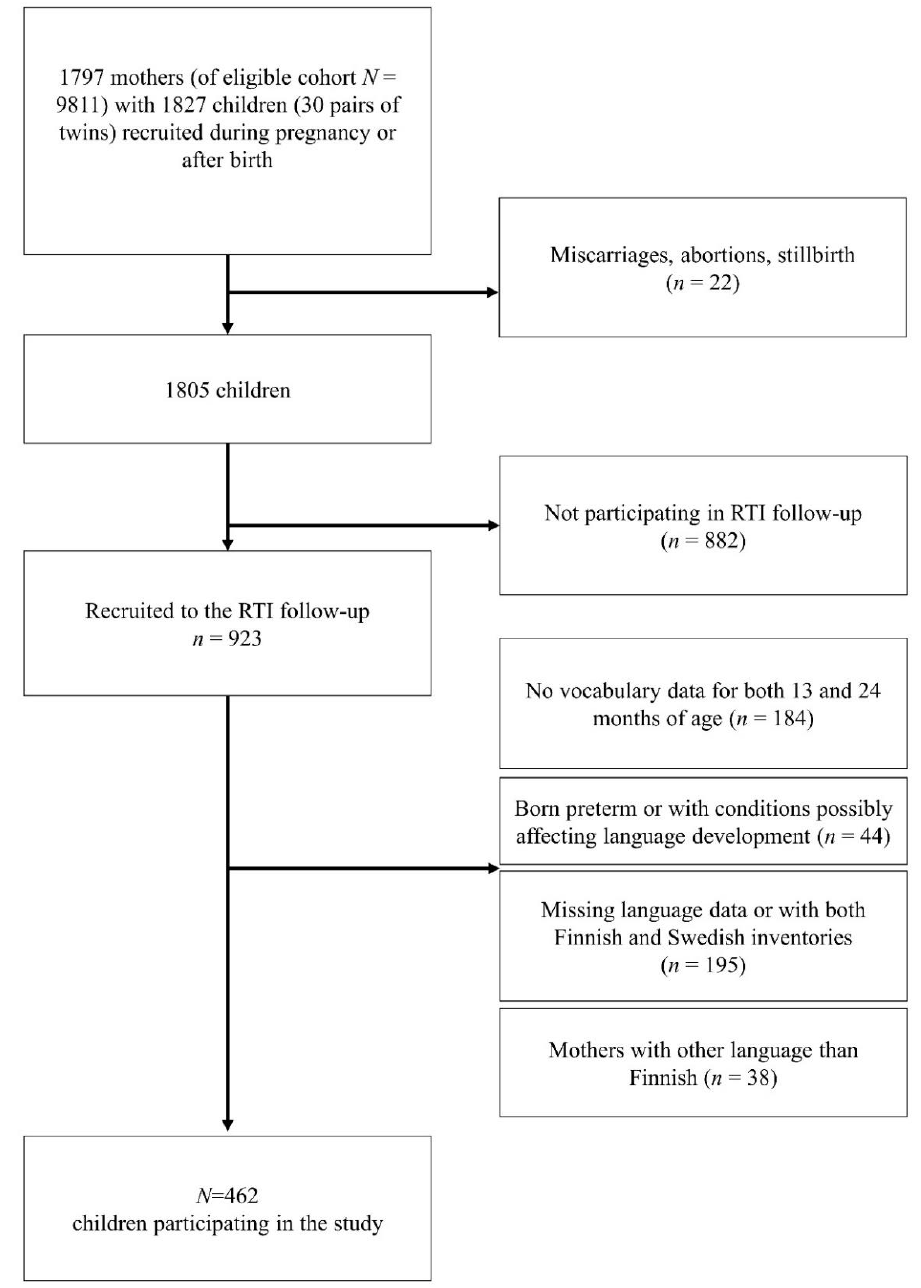
Figure 1. Flowchart of the recruitment procedure. RTI = respiratory tract infection.